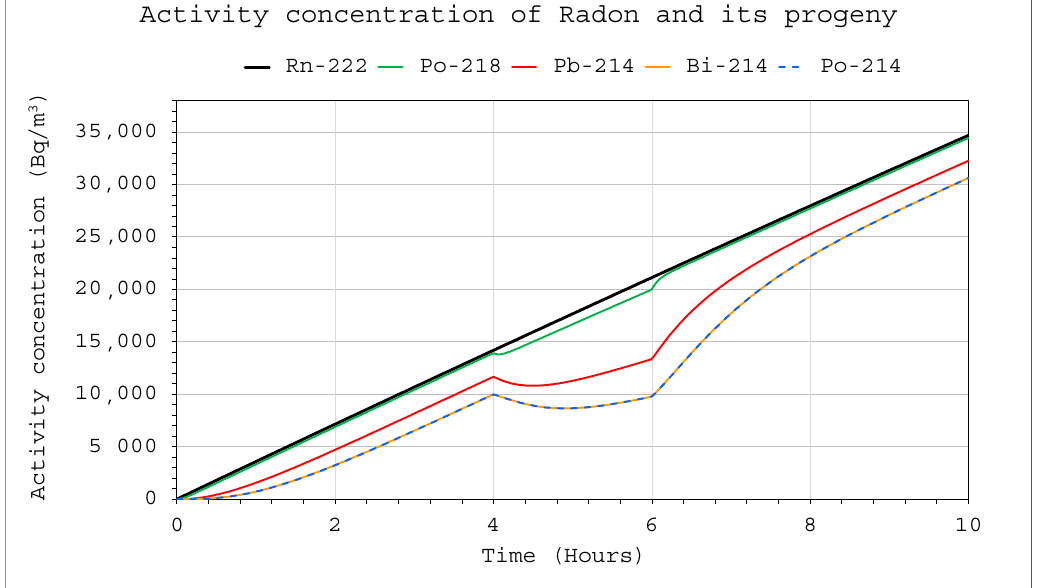
Figure 6. Activity concentration inside the system for the following conditions: E 1 = 1 Bq/s (contin- uously), V = 1 m 3 , C oi = 0. The device was operating in the range of 4–6 h with a flow rate of Q D = 10 L/min and a filtration efficiency of F = 100%.